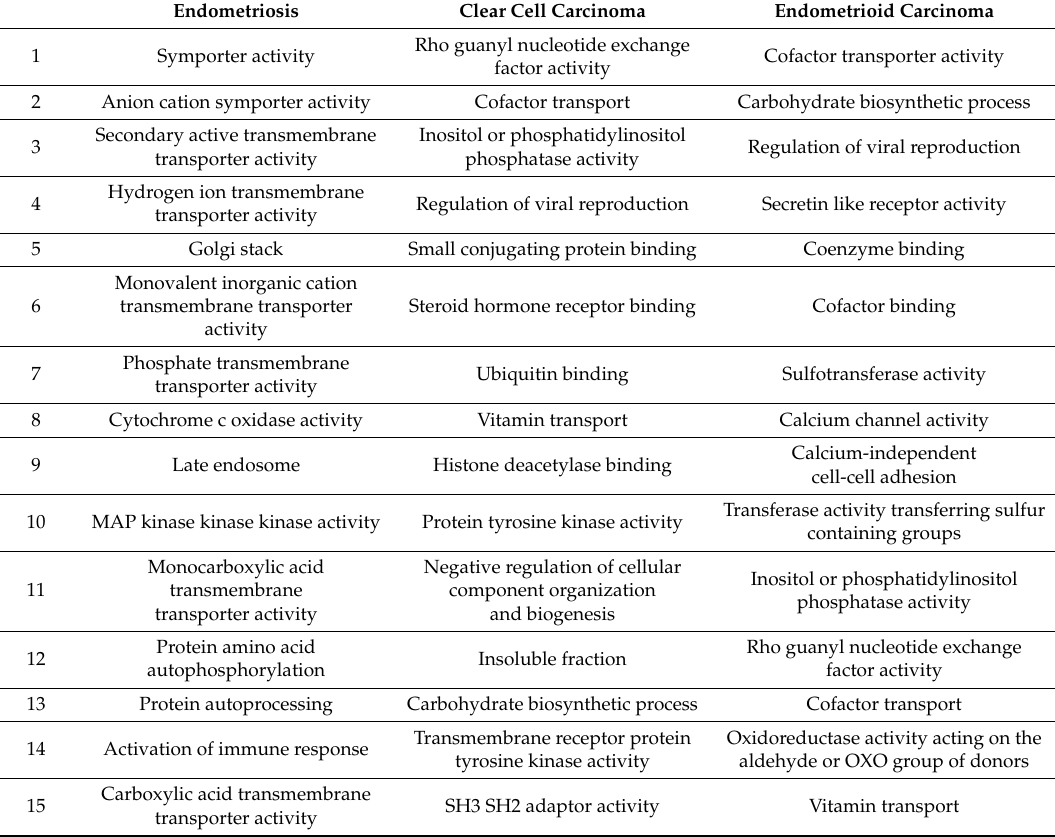
Table 2. The 15 most deregulated Gene Ontology terms for the three diseases ranked by p -values. Endometriosis Clear Cell Carcinoma Endometrioid